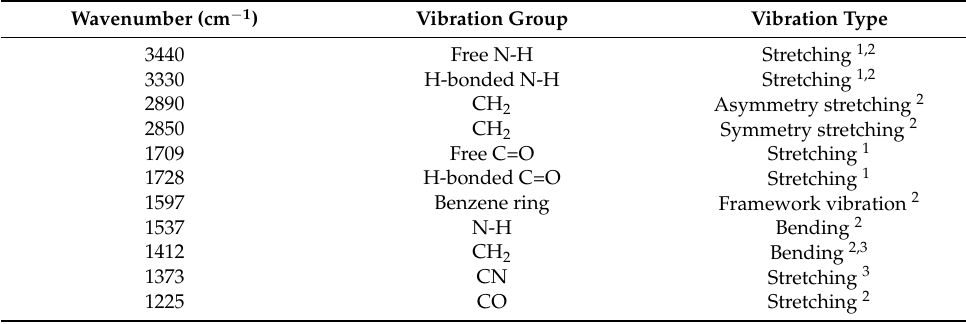
Figure 4. Room temperature absorbance spectrum of the polyurethane. Table 1. Characteristics of transition bands of PU according to references.